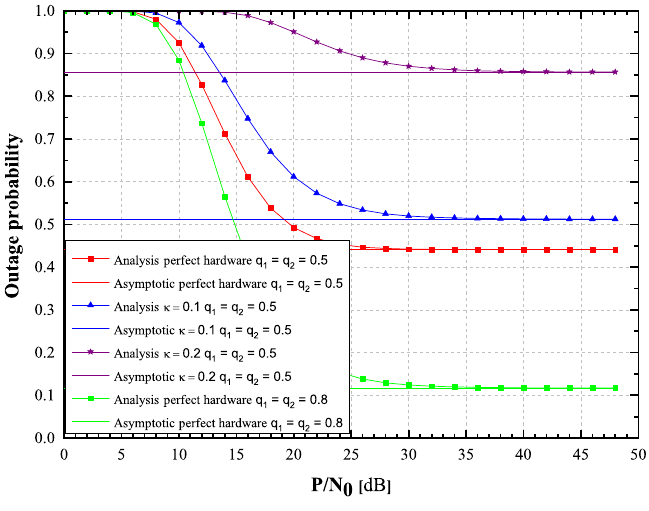
Figure 2. Hoyt fading channels: Outage probability versus P / N 0 , 2019 IEEE [24].